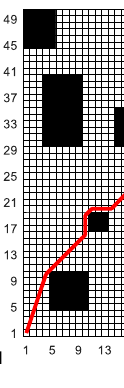
Figure 20. Mobile robot uses MPMGA for local path replanning.